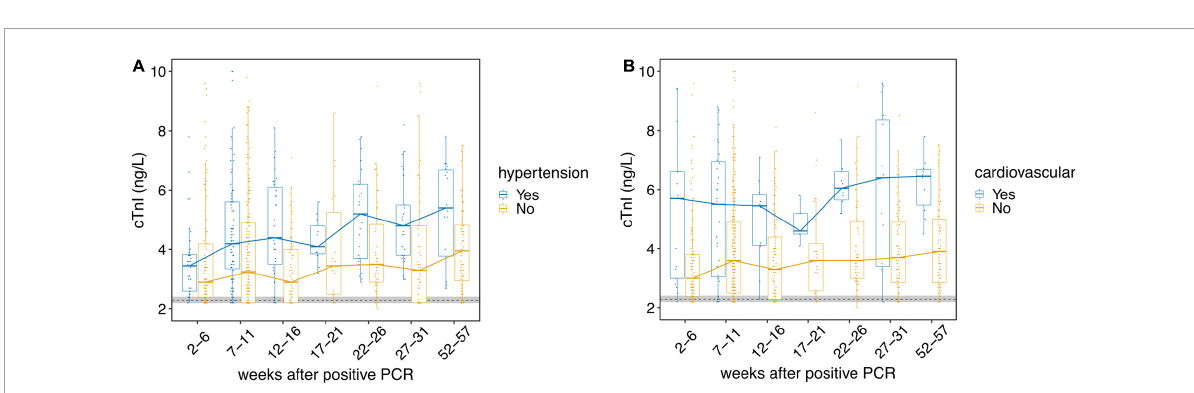
FIGURE3 The course of hs troponin I concentrations according to different co-morbidities. The course of hs troponin I concentrations (cTnI) over a period of more than 1 year [high sensitive (Beckman Coulter Switzerland, Nyon, Switzerland] assay) after mild to moderate SARS-CoV-2 infections depending on different co-morbidities is presented. Black dotted line indicate the limit of detection and limit of quantification, both at 2.3 ng/L. Horizontal bold lines indicate median values; boxes indicate quartiles 1 and 3; whiskers indicate 1.5 × IQR confidence intervals (CI). Gray shaded region indicate the 95% CI of the cTnI of the control cohort ( n = 115). Each point represents a single measurement. (A) The cohort is split by data from the survey indicating hypertension (Yes, blue) or no hypertension (No, yellow). The course of cTnI over time is presented. (B) The cohort is split by data from the survey indicating an occurrence of a known cardiovascular disease (Yes, blue) or no cardiovascular disease (No, yellow). The course of cTnI over time is